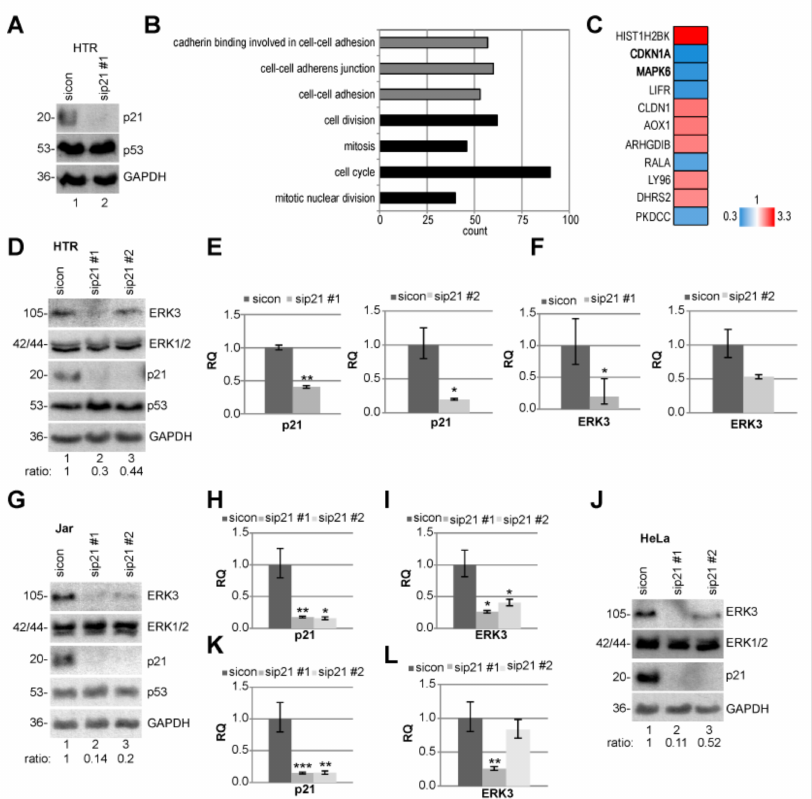
Figure 5. Extracellular signal-regulated kinase 3 (ERK3) is reduced in p21-depleted cell lines. ( A – C ) Microarray analysis. HTR cells were treated with sicon or sip21 #1 for 48 h and the RNA from three independent experiments was extracted. ( A ) Western blot control of HTR cells with glyceraldehyde-3-phosphate dehydrogenase (GAPDH) as loading control. ( B ) The e ff ects of sip21 #1 on di ff erent pathways were determined by gene ontology enrichment analysis using Database for Annotation, Visualization and Integrated Discovery (DAVID) [37]. ( C ) Heatmap of the most di ff erently expressed genes. Gene expression was analyzed using HumanHT-12 v4 beadchip array (Illumina, San Diego, CA, USA). Genes with a p -value < 0.01, and a fold change greater than 2 (red color code) and below 0.5 (blue color code), respectively, are included. ( D ) Western Blot of HTR cells treated with control siRNA (sicon) or two distinct siRNA against p21 (sip21 #1 or #2) for 48 h. Ratio of ERK3 / GAPDH is shown. GAPDH served as loading control. ( E , F ) The gene levels of p21 (E) and ERK3 (F) were measured. ( G ) Western blot analyses of Jar cells treated as in (D). ( H , I ) The gene levels of p21 (H) and ERK3 (I). ( J ) Western blot analyses of HeLa cells treated as in (D). ( K , L ) The gene levels of p21 (K) and ERK3 (L). The mRNA data are based on three experiments and presented as RQ with minimum and maximum range. RQ: relative quantification of gene expression. * p < 0.05, ** p < 0.01, *** p <